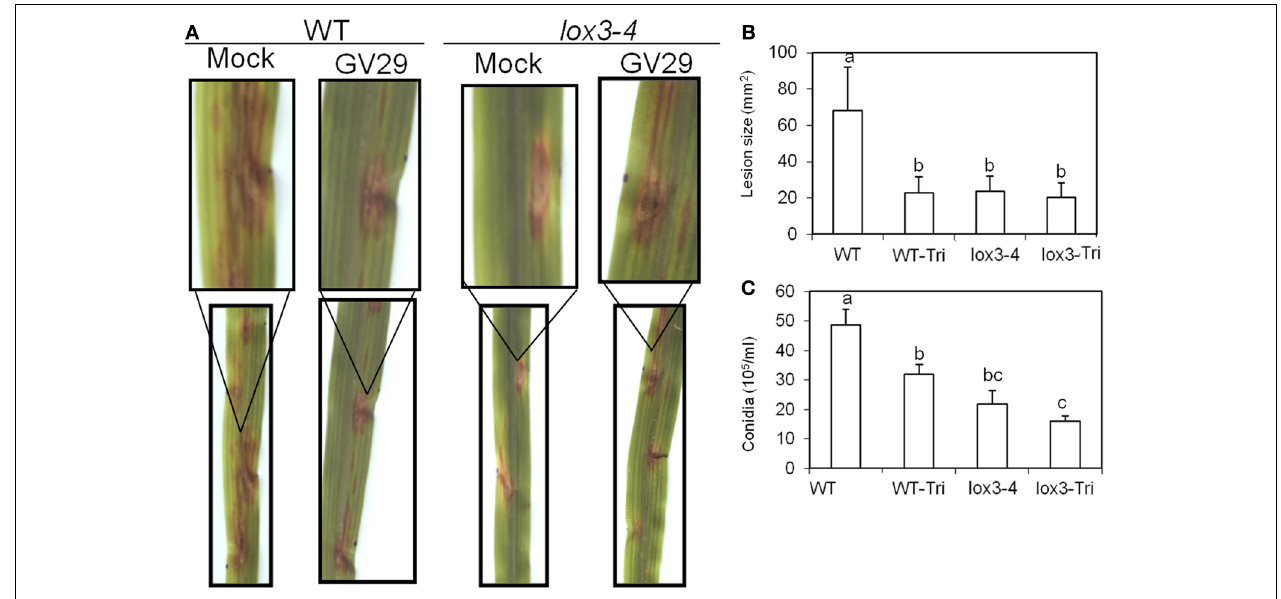
FIGURE 4 | Effect of colonization of roots of lox3-4 mutant and B73 plants on the pathogenicity of C. graminicola infected on the leaves. Approximately 3-week-old lox3-4 mutant and B73 seedlings at 4 true leaf stage were treated with T. virens in the roots. Then the leaves of treated plants were infected with 10 μ l of C. graminicola conidial suspension at 1 × 10 6 spores/ml at 3 days post treatment. (A) The disease symptoms were recorded and photographed at 3 days post infection. The insert panels show the close-up of representative lesions showing on the corresponding